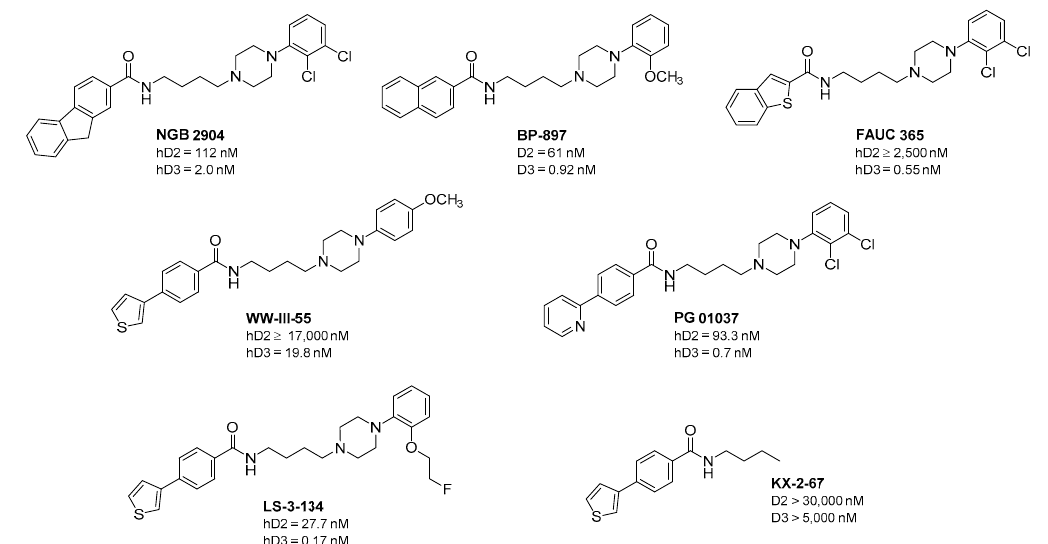
Figure 1. Chemical structures and binding data of a variety of arylamide phenylpiperazine D3 dopamine receptor selective compounds are shown. KX-2-67 binds with low affinity to the secondary binding site of the D3 dopamine receptor [19,20,26,27,30].